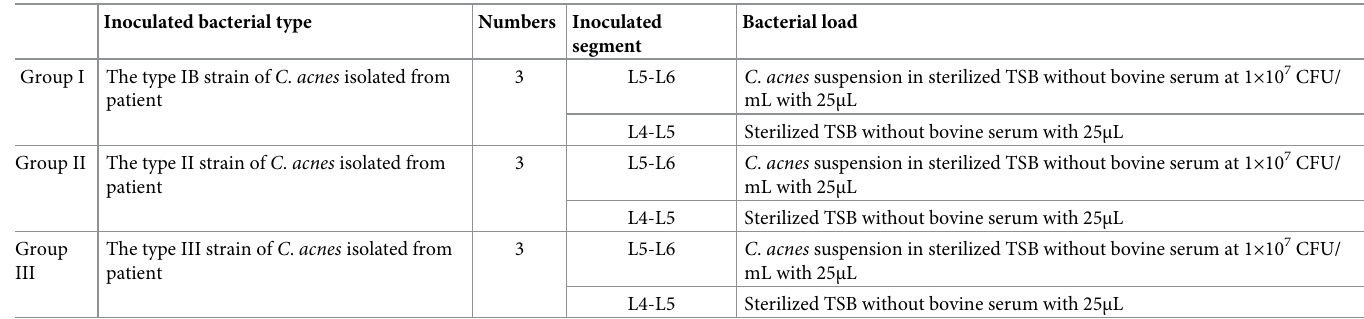
Table 1. Animal group